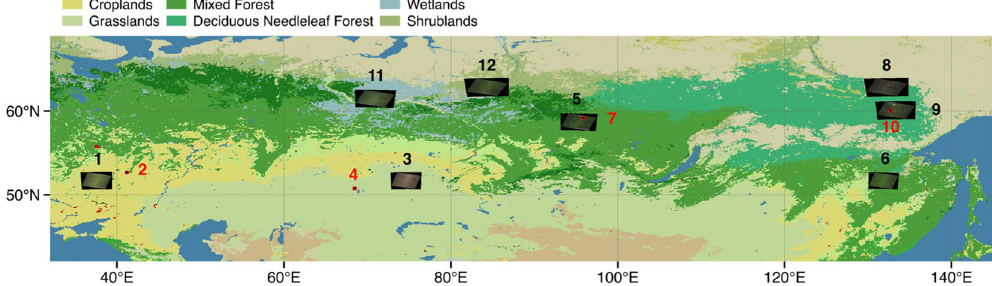
Figure 1. Distributions of 12 validation regions in boreal Eurasia over a wide range of vegetation types. Landsat 7 ETM + reference images are numbered in black. Reference images from commercial satellite products are numbered in red. Only the major vegetation types studied in this work are labelled. Vegetation type data are from the MODIS MCD12Q1 product. Detailed information of the 12 regions is presented in Table S1. The figure is created using QGIS 2.14.0